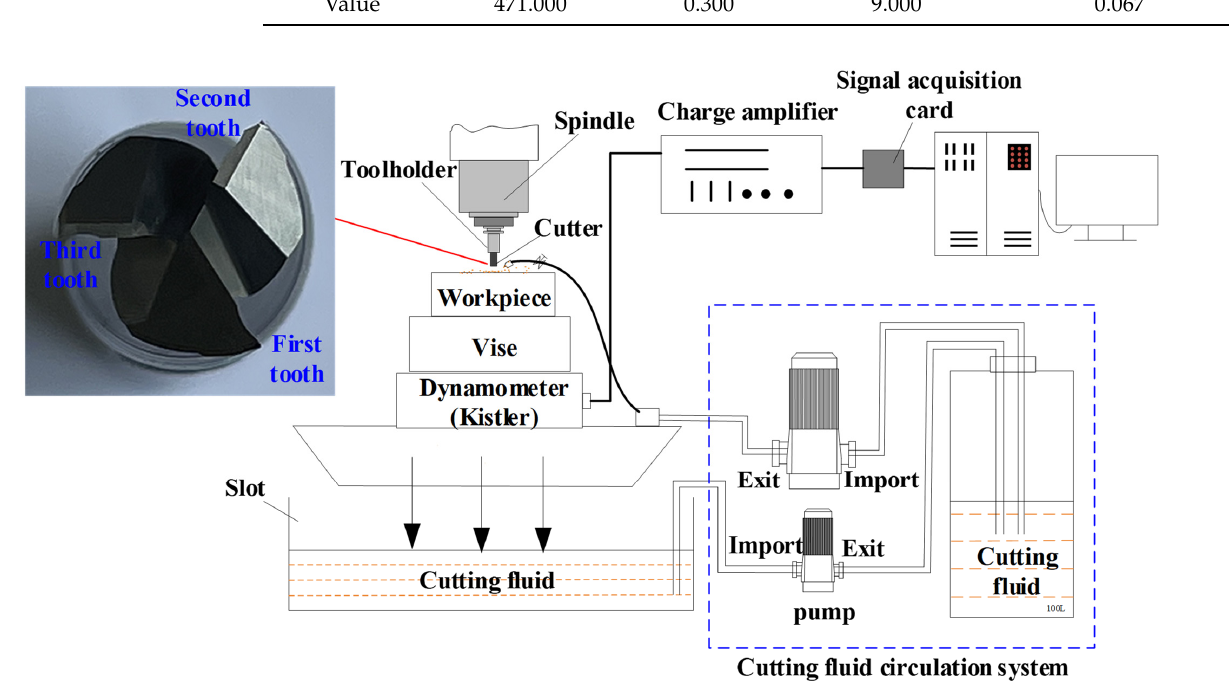
Figure 1. Schematic diagram of the entire machining system.